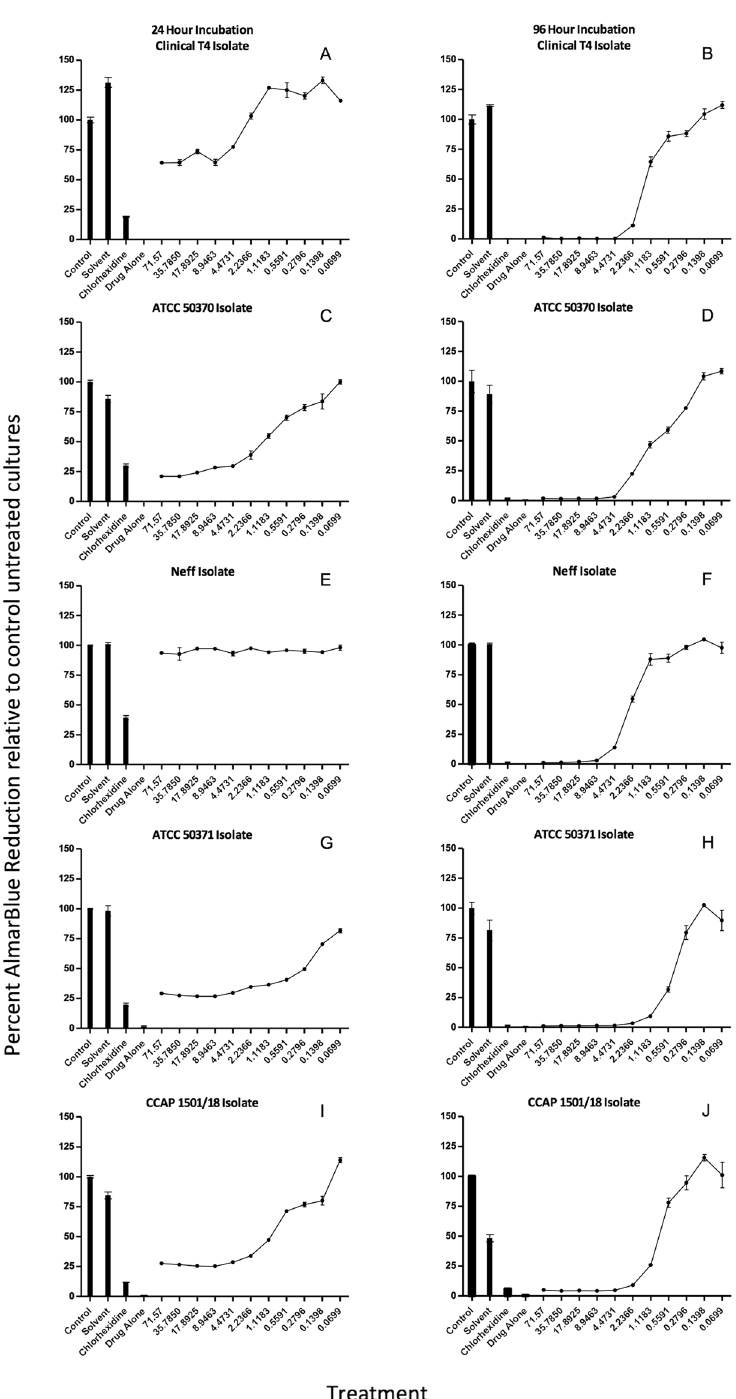
Figure 3. Representative dose response curves, showing the effect of voriconazole on 5 Acanthamoeba isolates (clinical T4, ATCC 50370, Neff, ATCC 50371 and CCAP